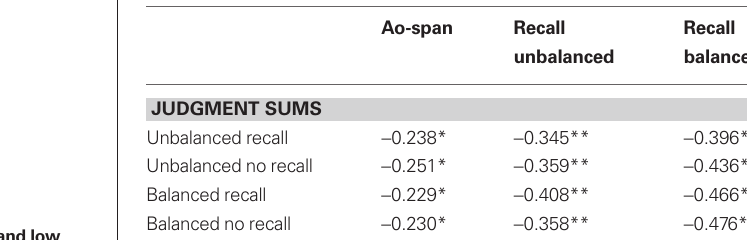
Table 5 | Pearson r correlations among automated operation-span, number of items recalled, and subadditivity for experiment